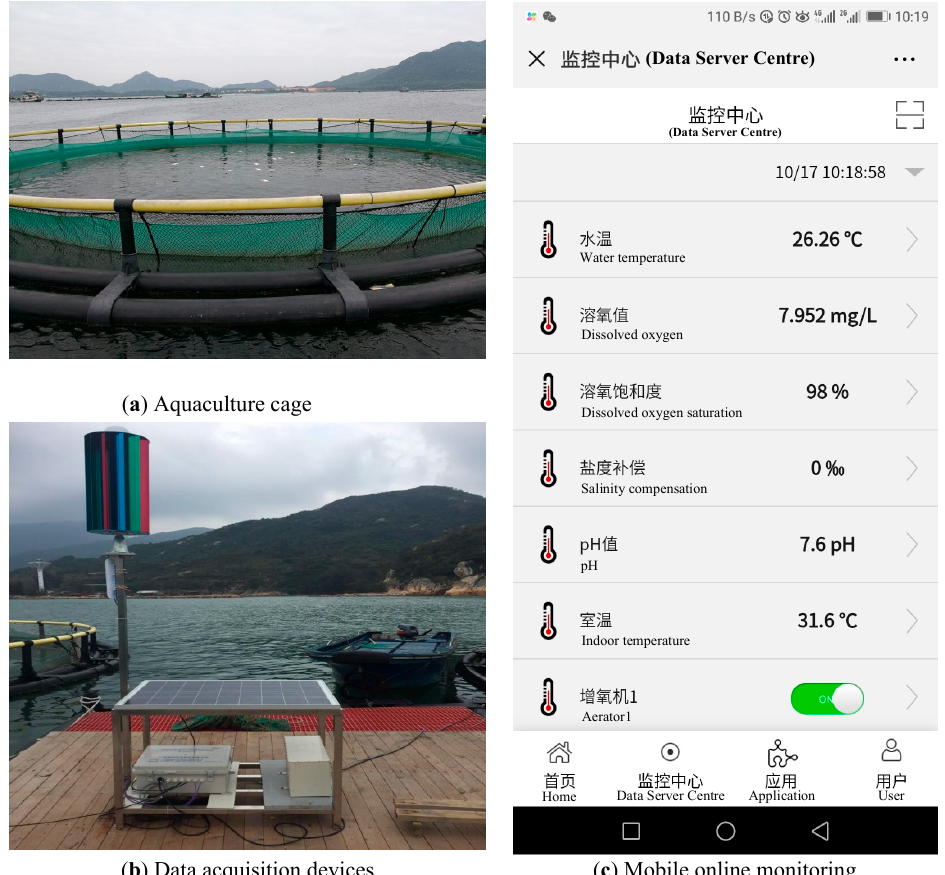
Figure 1. Experimental data acquisition site and software.